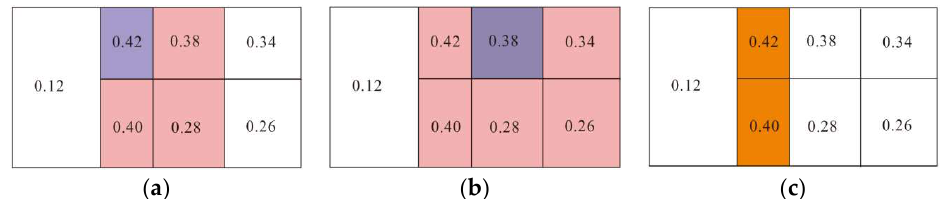
Figure 5. Schematic diagram of redefining starting meshes: ( a ) first-order adjacent field for the mesh with a density of 0.42; ( b ) first-order adjacent field for the mesh with a density of 0.38; and ( c ) the new starting meshes.